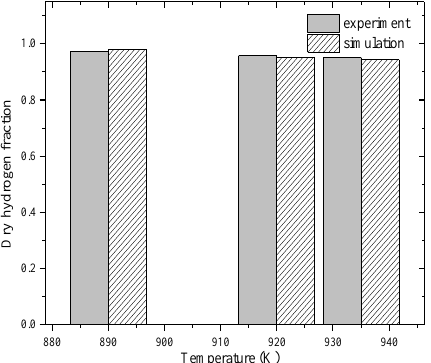
Figure 3. Experimental fluidized bed configuration.